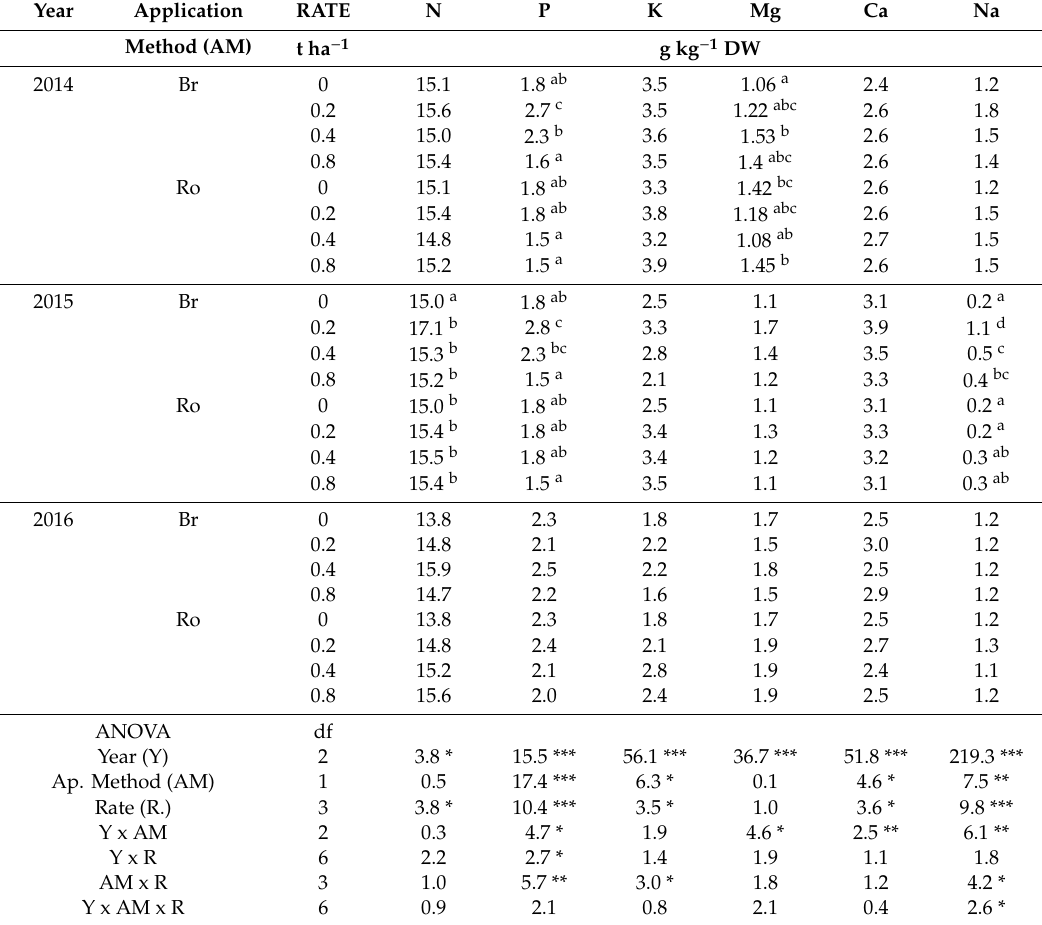
Table 6. Response of macronutrient concentration in maize grain to digestate application method and